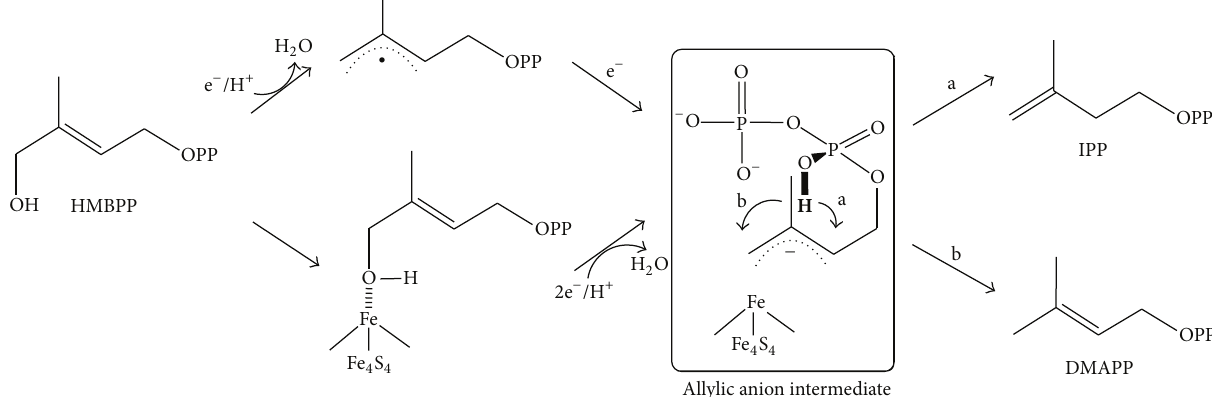
Figure 5: Proposed IspH-catalyzed reaction mechanism of isopentenyl diphosphate biosynthesis. Steps a and b represent possible proton transfer pathways to the allylic anion intermediate, which results in different product